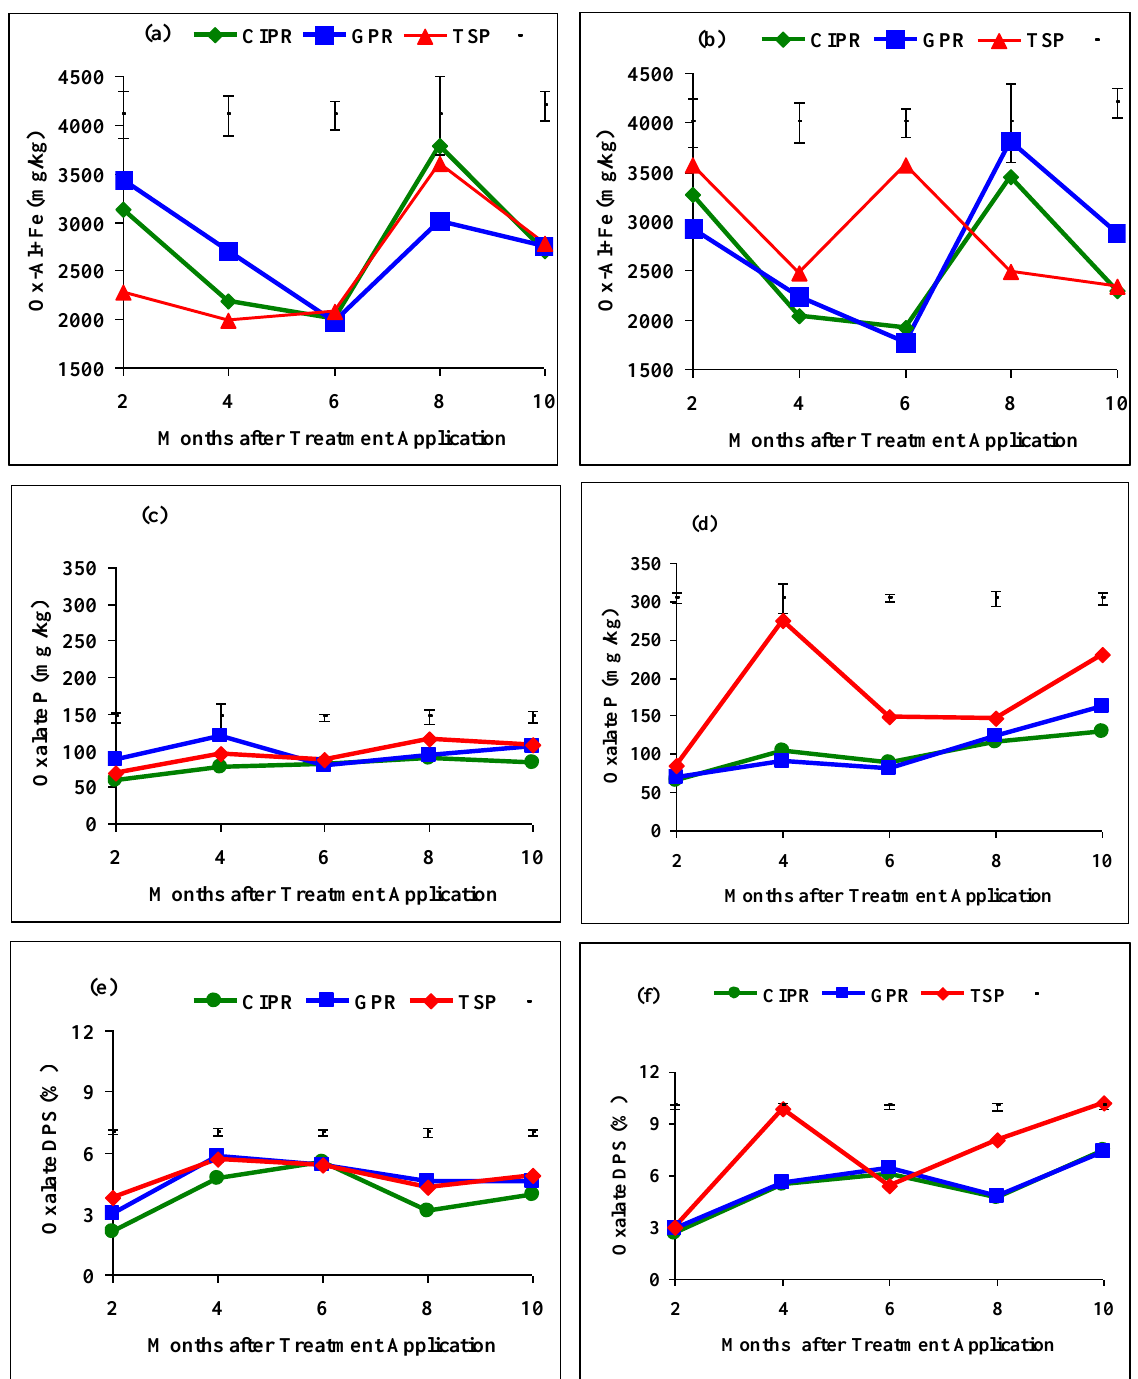
FIGURE 4. Effects of P source  time at 100 and 300 kg P ha -1 , respectively, on (a,b) oxalate Al + Fe, (c,d) oxalate P, and (e,f) oxalate